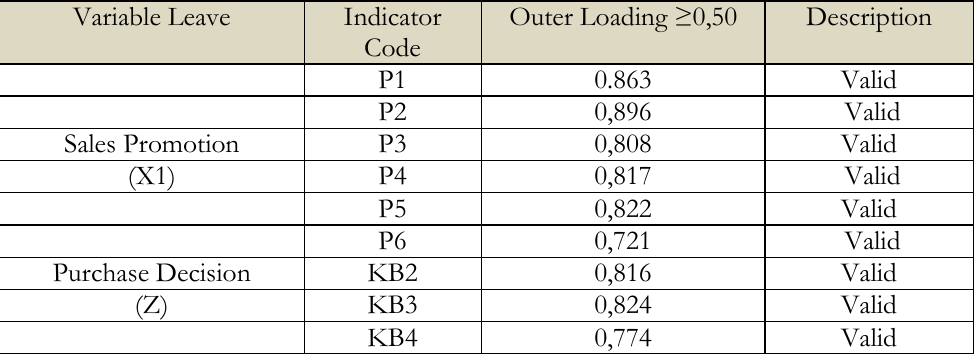
Table 2 Convergent Validity Test Results